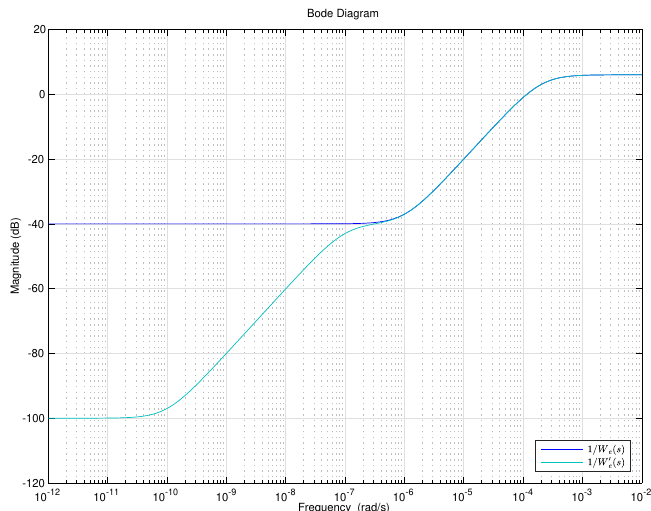
Figure 17. Comparison between the two weighing function, 1/ W e ( s ) and 1/ W (cid:48) e ( s ) frequency responses.